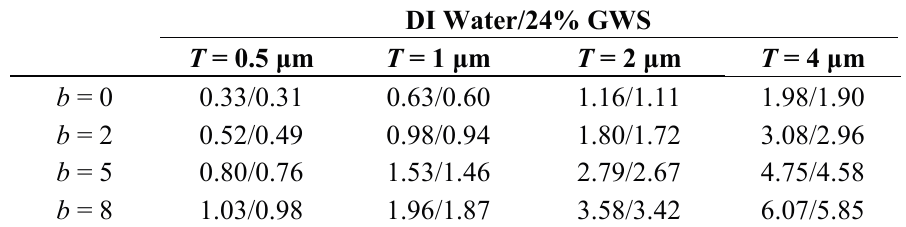
Table 2. The achievable mass sensitivities of the cantilever mass sensors made of silicon with L = 200 μ m, W = 30 μ m, and thicknesses T = 1, 2, and 4 μ m in DI water and 24% glycerol-water solution (GWS) of ρ l = 1.053 g/cm 3 and μ l = 1.984 Pa·s loaded by a